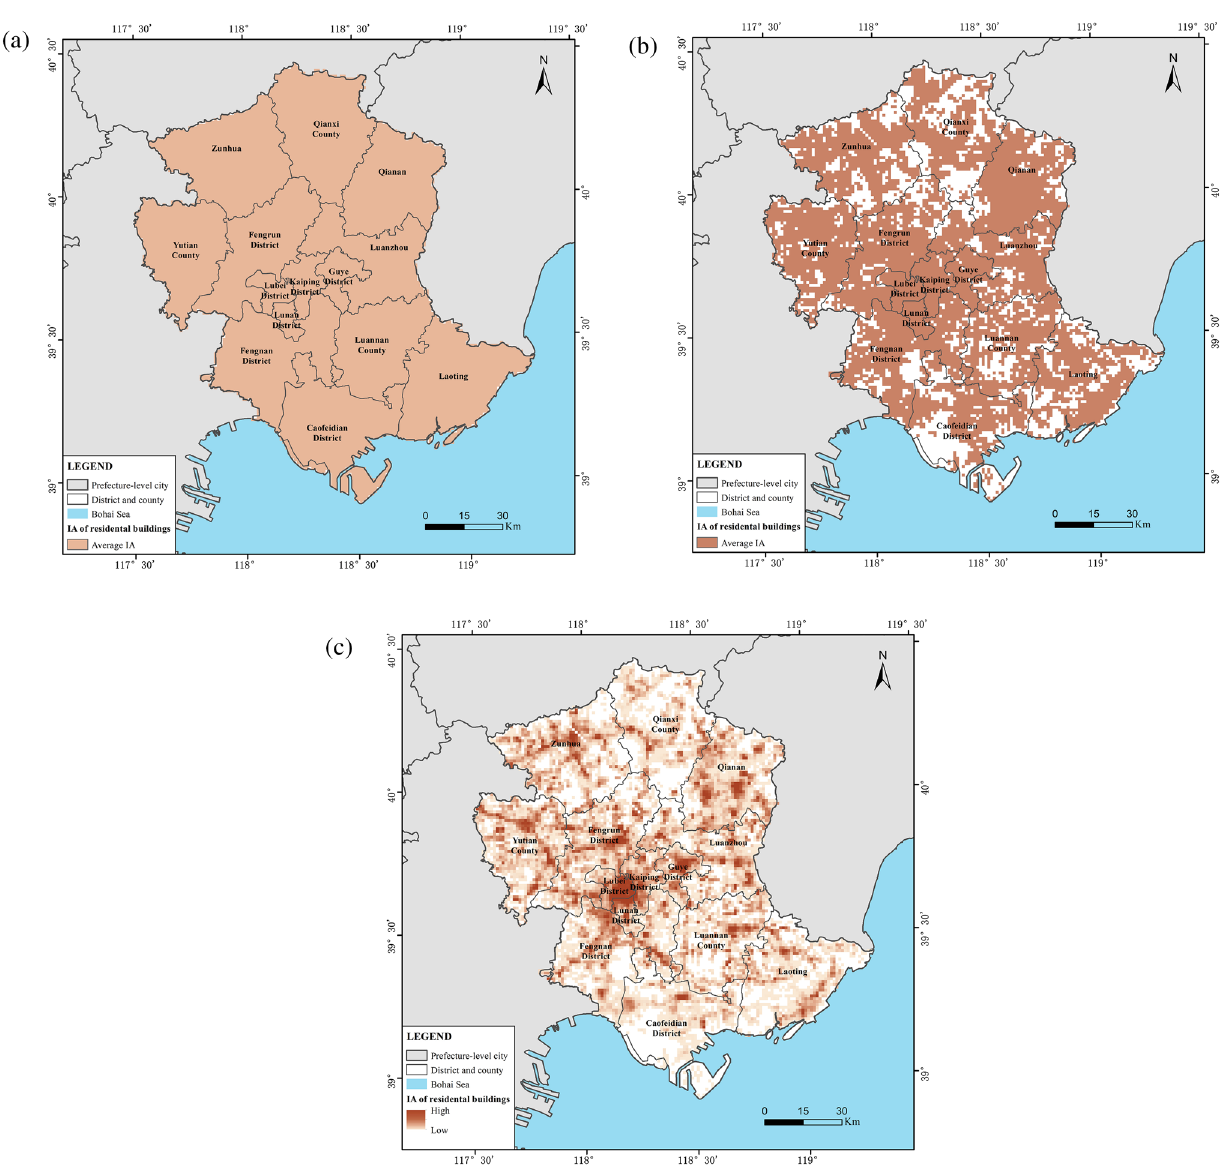
Fig. 5 Distribution of the insured amount (IA) of the residential buildings in three situations: a Distribution of the IA in Situation 1; b Distribu- tion of the IA in Situation 2; c Distribution of the IA in Situation